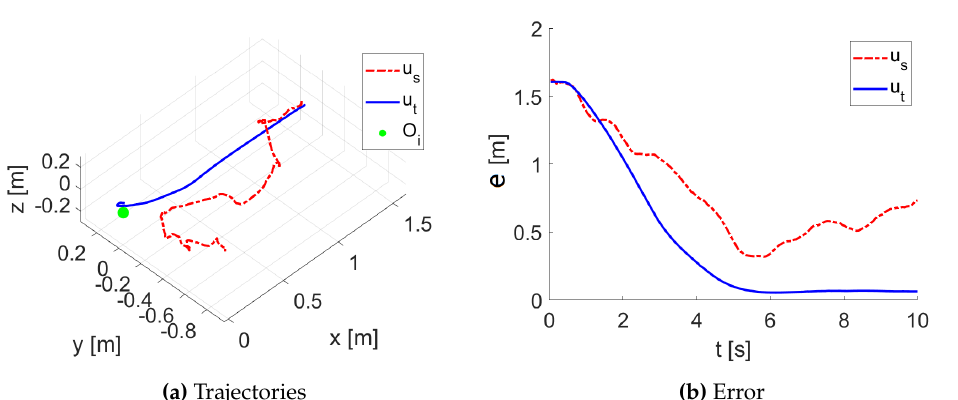
Figure 20. An example of trajectory and position regulation error from tank